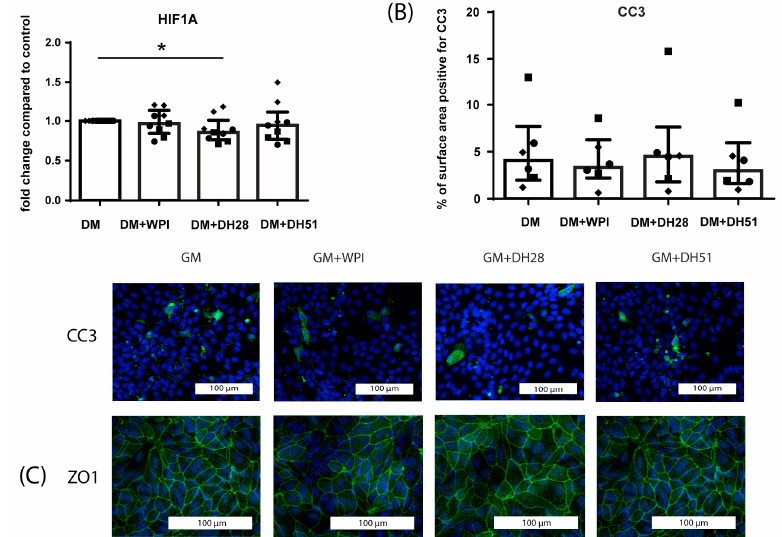
Figure 9. Effect of WPI, DH28 and DH51 on villus-like HIO (monolayer-cultured) in a diseased setting (hypoxia). ( A ) mRNA expression of IL8 (pro-inflammatory cytokine), OLFM4 (stem cells), LYZ (Paneth cells), PEPT1 (di/tri-peptide transporter), LAT2 (amino acid transporter) and HIF1A (hypoxia-regulated transcription factor) in villus-like HIO monolayers exposed to hypoxia (48 h) and WPI, DH28 or DH51 (48 h) compared to control. Data are reported as relative expression compared to control (set at 1) and displayed as median with interquartile range. Results were obtained from 3 different HIO donors (depicted by different data point symbols, one symbol type per donor). * p ≤ 0.05. ( B ) Analysis of the % of surface area positive for CC3 and representative images from immunofluorescence staining of CC3 in villus-like HIO monolayers exposed to hypoxia (24 h) and WPI, DH28, or DH51 (24 h) compared to controls. Data are displayed as median with interquartile range. Results were obtained from 3 different HIO donors (depicted by different data point symbols, one symbol type per donor). Scale bars indicate 100 µ m. ( C ) Representative images from immunofluorescence staining of ZO1 in villus-like HIO monolayers exposed to hypoxia (24 h) and WPI, DH28, or DH51 (24 h) compared to controls. Results were obtained from 3 different HIO donors. Scale bars indicate 100 µ m. Abbreviations: IL8—interleukin 8; OLFM4—olfactomedin